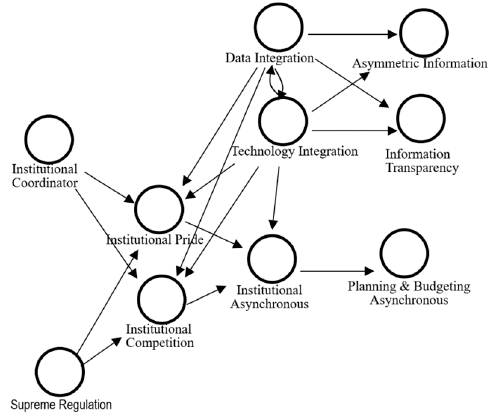
Figure 2. Concept Mapping.